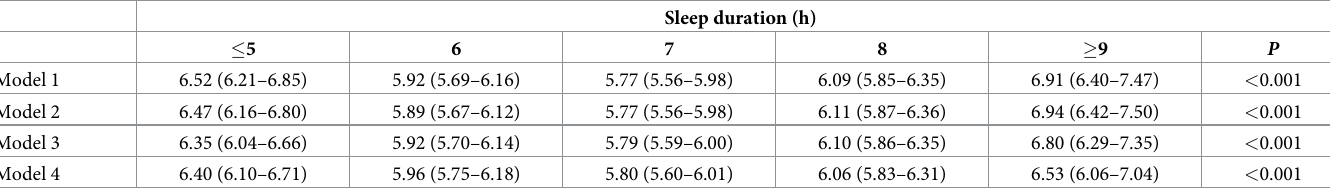
Table 2. Adjusted urinary albumin-creatinine ratio (UACR) levels according to sleep duration.